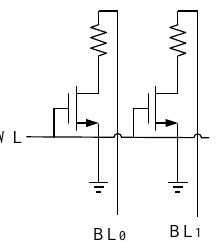
Figure 5. 2T2R structure of PCM for multilevel storage.